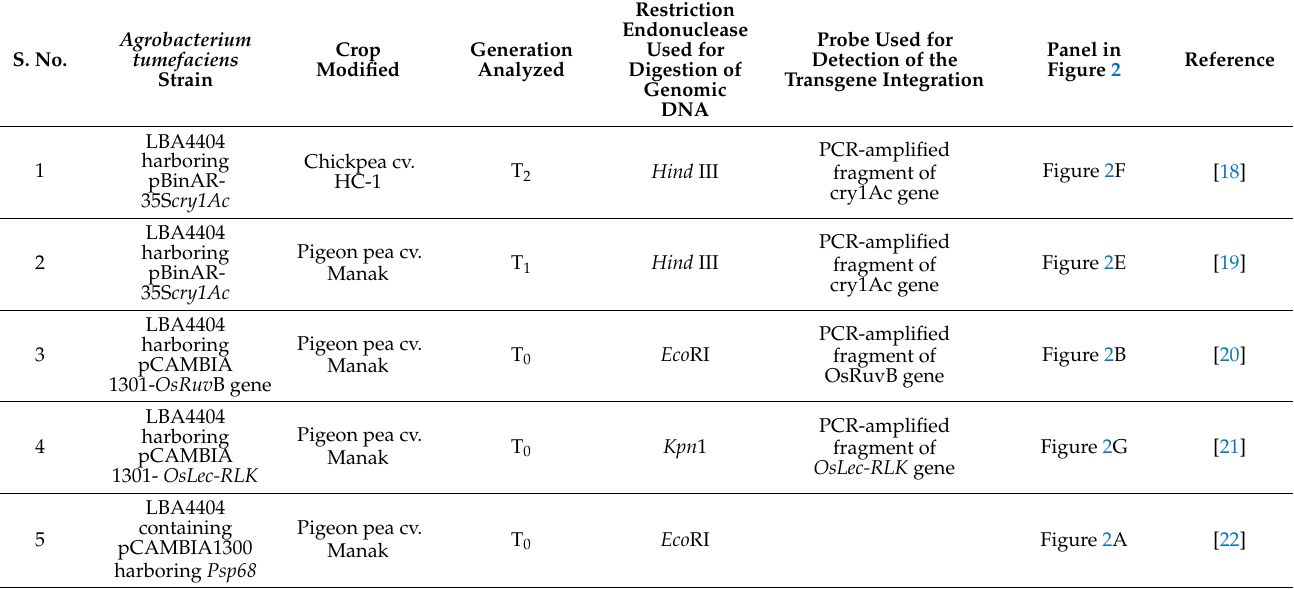
Table 3. Details of Southern hybridization analysis conducted in transgenic lines developed using the reported